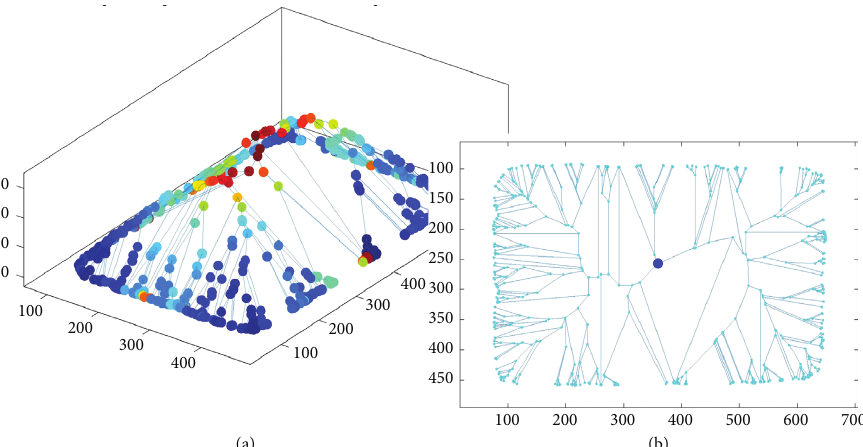
Figure 3: Terrain model induced by a straight skeleton. Center of Euclidean graph based on closeness centrality